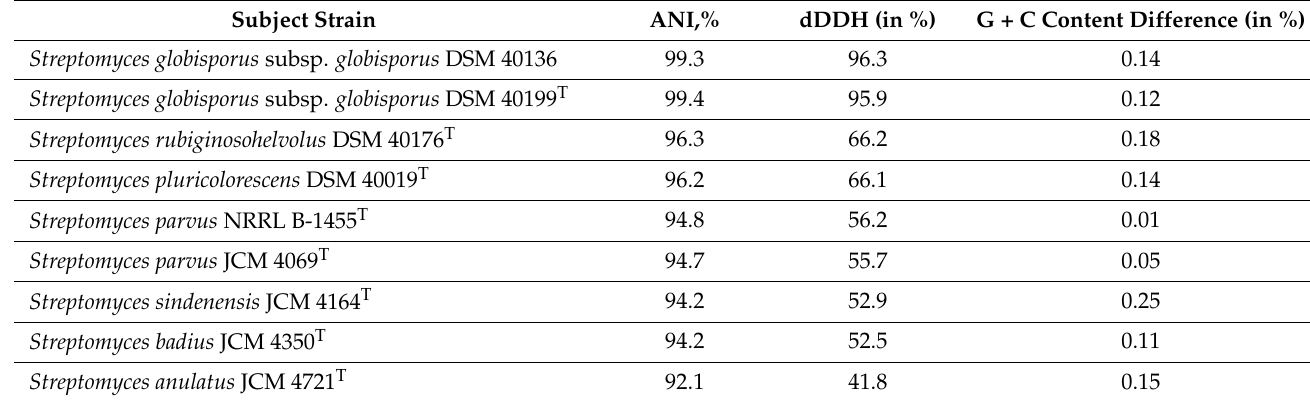
Table 1. Genome relatedness of 4-3 and Streptomyces type-strains.